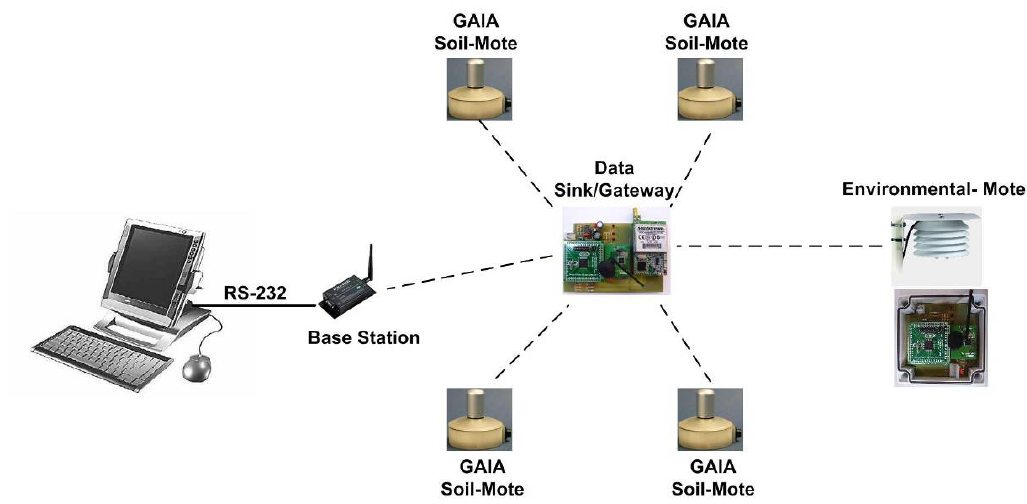
Figure 3. The system architecture for the laboratory